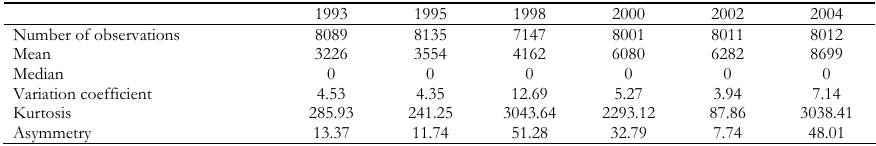
Debt of Italian households from 1993 to 2004, thousand euro